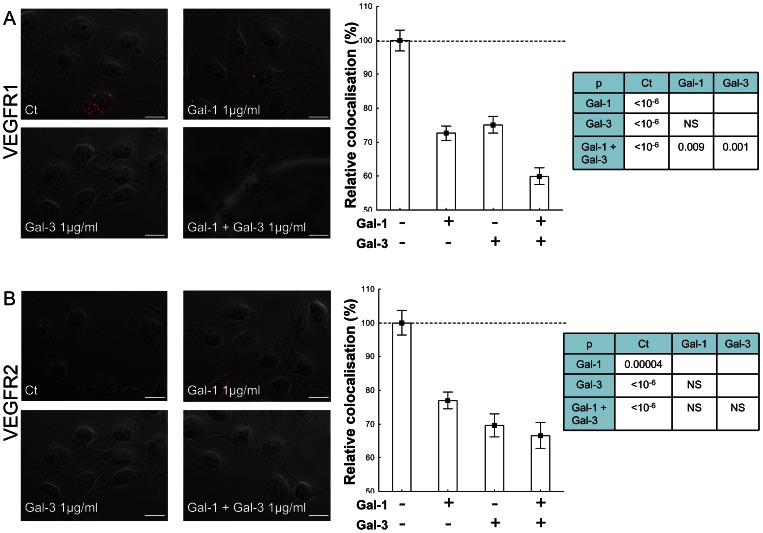
Modulation of VEGFR endocytosis by exogenous galectins in EA. hy926 cells.The effects of exogenous galectins (1 µg/ml each) were evaluated by analysing the colocalisation between each receptor and EEA1 using the proximity ligation assay and an image analysis tool. Representative images of z-stacks of 7 fluorescent micrographs projected into a single phase-contrast image (original magnification: ×60) are shown. Signal/cell values are shown as relative values (mean +/− SEM) compared with the control (no galectin addition). The tables show the significance levels obtained by applying the standard Dunn procedure (post-hoc test) to compare all the pairs of experimental conditions, in order to avoid multiple comparison effects (NS  =  not significant: p>0.05). Scale bar: 20 µm.